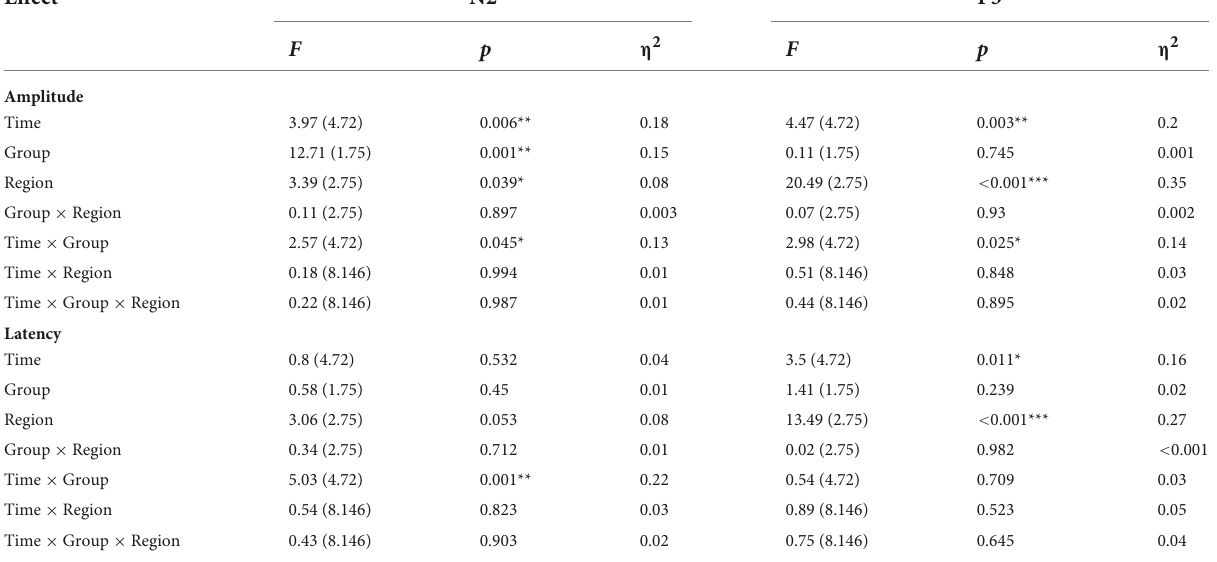
TABLE 6 Amplitude and latency of ERPs component for Go/Nogo